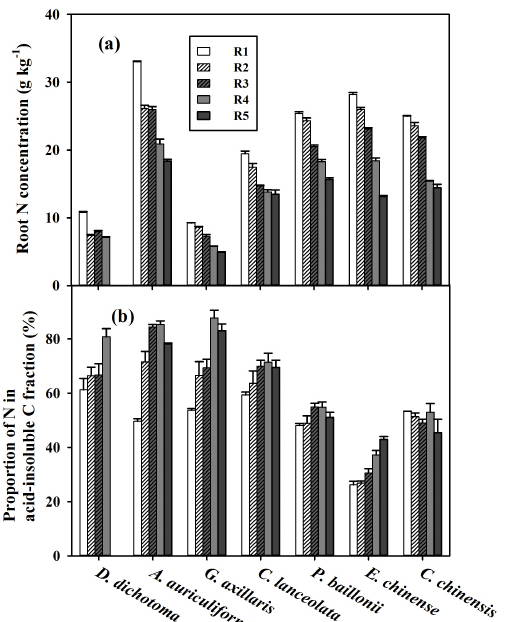
Figure 6. Root N concentration (a) and N in acid-insoluble C frac- tion (b) for the first five root branch orders for each of seven plant species. R1–R5 refer to the first to fifth